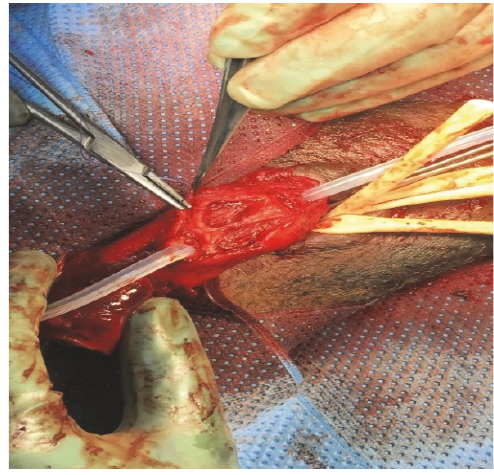
Figure 3: Closure of corpora cavernosa tears.